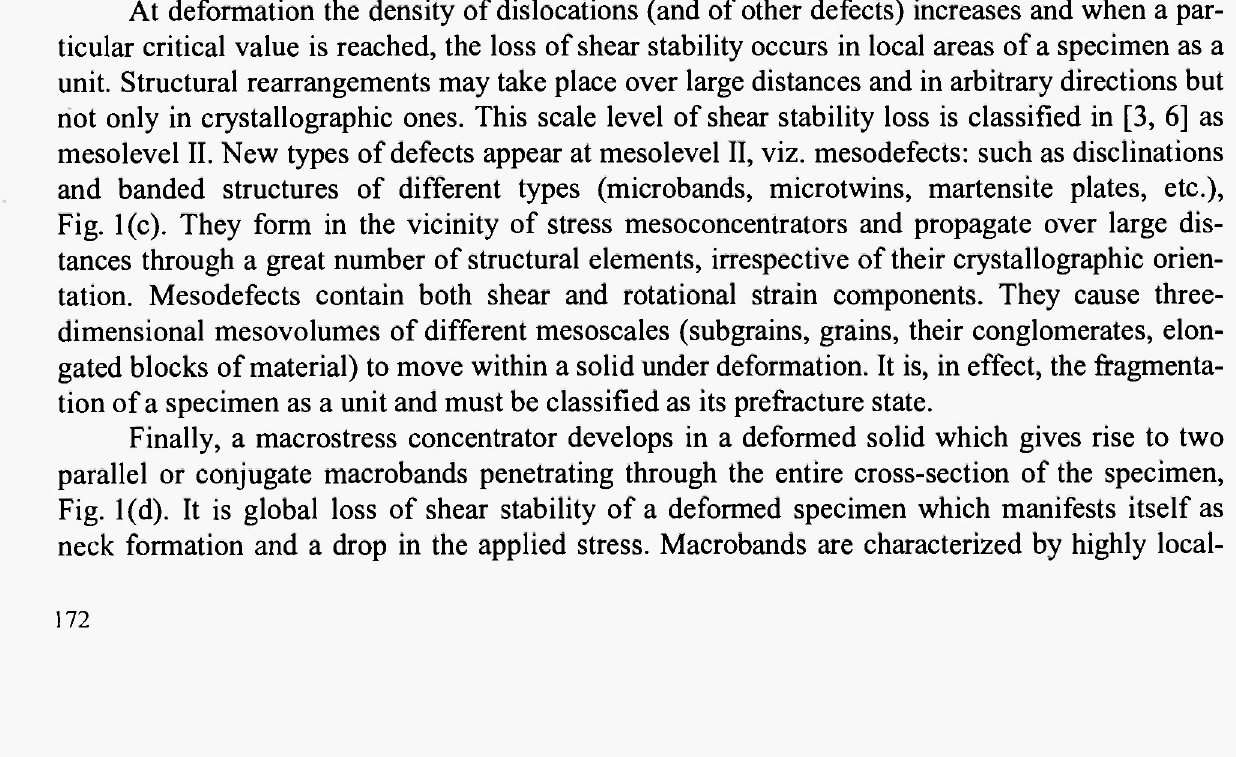
Figure 1: Schematic of scale levels of shear stability loss in deformed solid: micro (a); meso I (b), meso II (c), macro